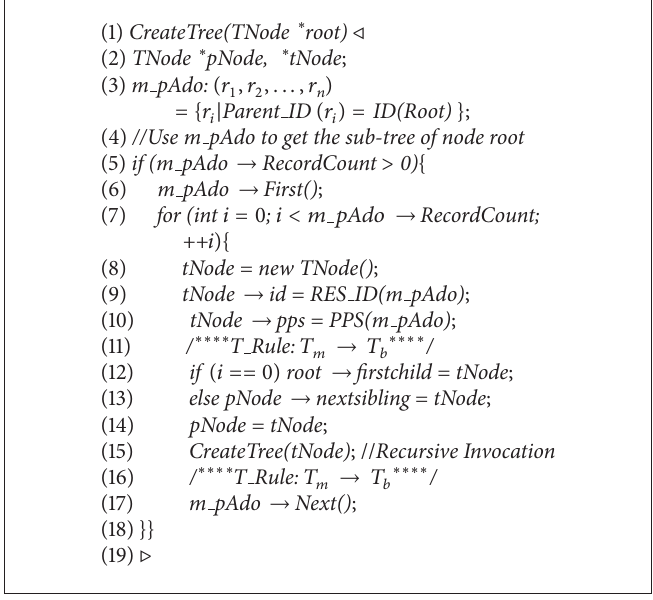
Algorithm 1: The spanning binary permission tree.